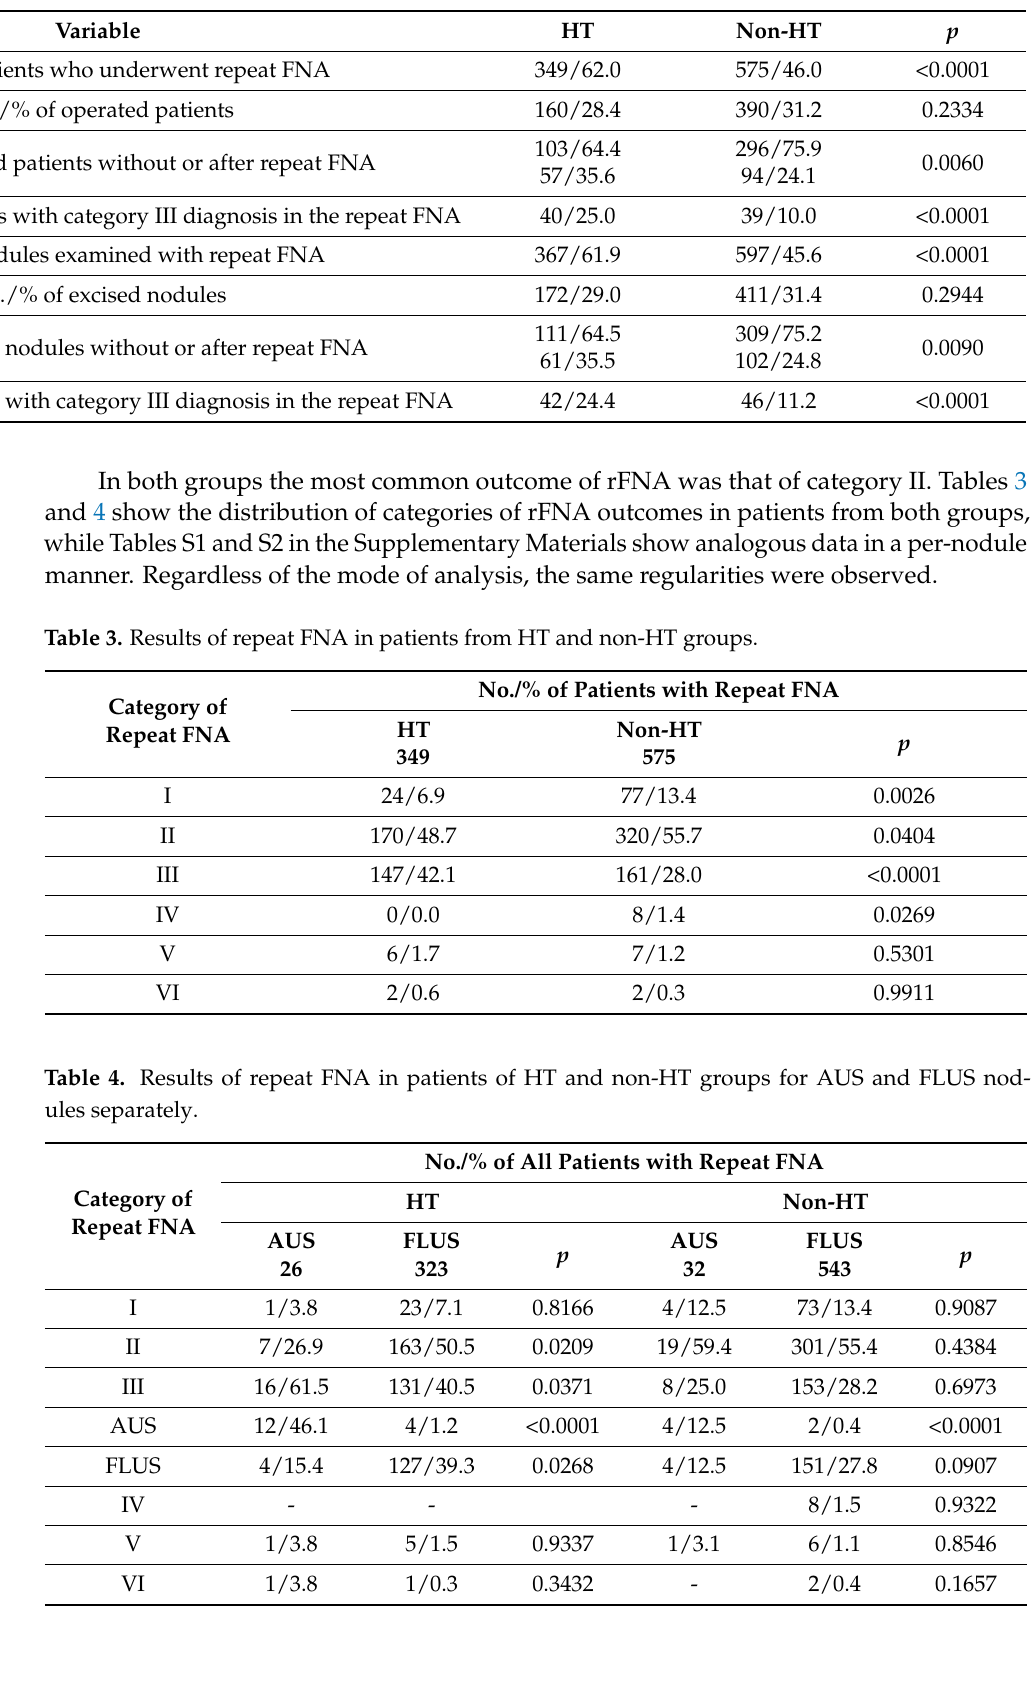
Table 2. Data on frequencies of repeat FNA and surgical treatment in the HT and non-HT groups.